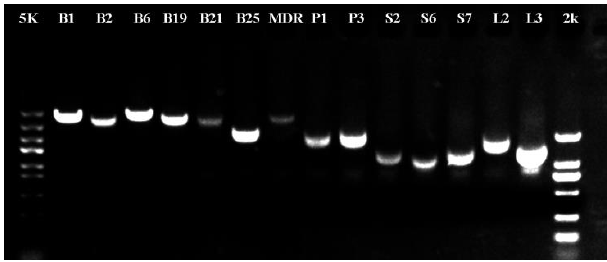
Figure 6. Full-length cDNA cloning of genes involved in polar auxin transport. 5 k: 5 kb marker; 2 k: 2